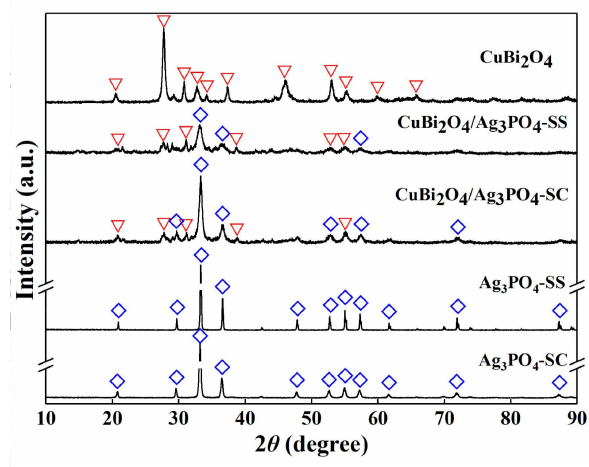
Figure 1. Powder X-ray diffraction (XRD patterns of the as-prepared